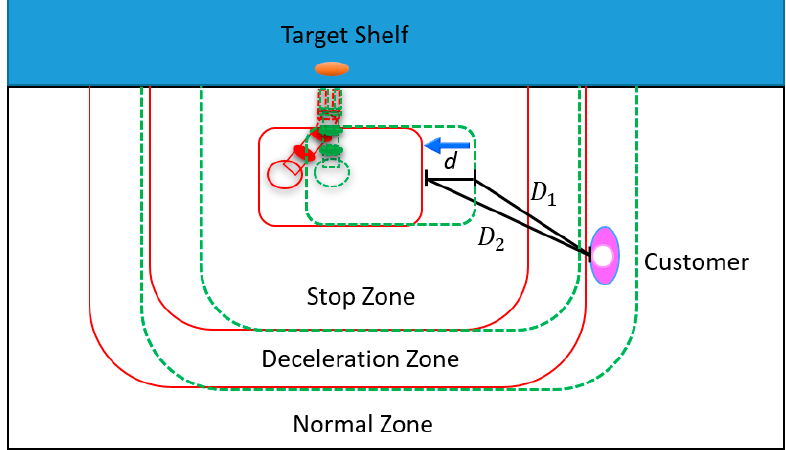
Figure 7. Illustration of how working e ffi ciency is raised.